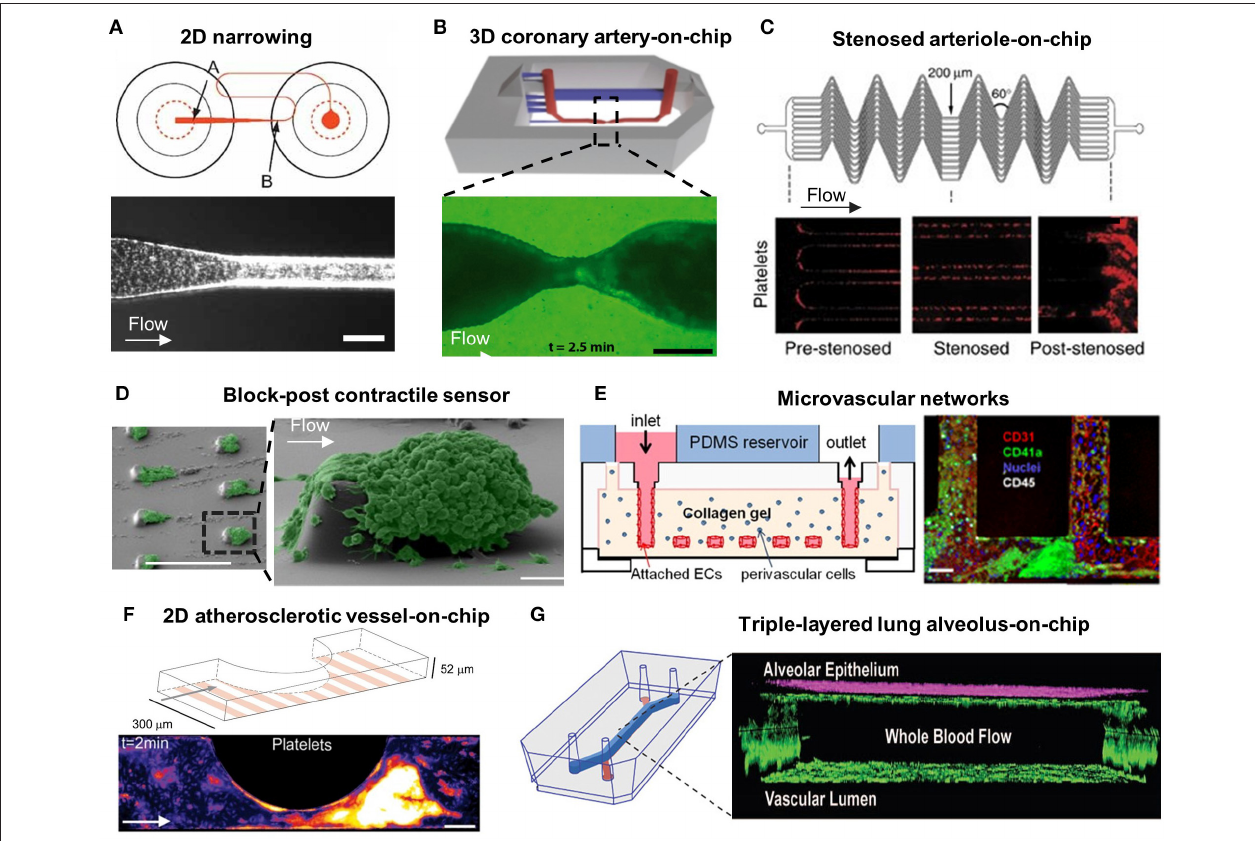
FIGURE 1 | Microfluidic models for the study of platelet mechanobiology and its interplay with circulatory system in thrombus development . (A) A 2D Narrowing channel from Conant et al. ( 70); Top: A well-plate microfluidic design, where arrow A indicates microfluidic channel entrance and arrow B indicates the neckdown region; Bottom: Platelet behavior at the neckdown zone. Scale bar = 100 µ m. (B) A 3D coronary artery-on-chip model from Costa et al. ( 56); Top: Animation image of the 3D microfluidic model; Bottom: Fluorescence image of platelet aggregation at stenosis. Scale bar = 200 µ m. (C) Stenosed arteriole mimicking microfluidic device from Jain et al. ( 71); A network of parallel stenosed microchannels which contain multiple regions of pre-stenosis, stenosis and post-stenosis. (D) Block-post contractile sensor from Ting et al. (40); SEM images of platelet aggregation on a micropost microfluidic device. Scale bar = 10 µ m. (E) Microvascular networks from Zheng et al. (67); Left: Schematic of the multiple-layered collagen network in the microfluidic device; Right: Confocal image of the endothelialized microfluidic channel with platelet (green), leucocytes (white) adhesion and aggregation. Scale bar = 50 µ m. (F) A 2D atherosclerotic vessel-on-chip model from Westein et al. (6); Left: Schematic diagram of microfluidic device incorporating microchannels with varying degrees of stenosis (20–80%); Right: Confocal images of platelet aggregates at the endothelialized stenotic region upon blood perfusion. Scale bar = 100 µ m. (G) Triple-layered lung alveolus-on-chip model from Jain et al. ( 61); Left: Schematic of the three-layered alveolus-on-a-chip model; Right: Confocal image of endothelial and epithelial cell coculture in the